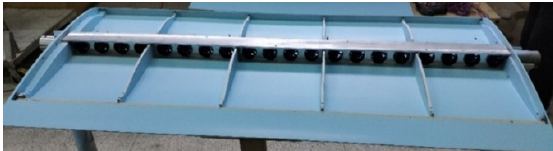
Figure 4. Interior of DCFJ312 airfoil model.